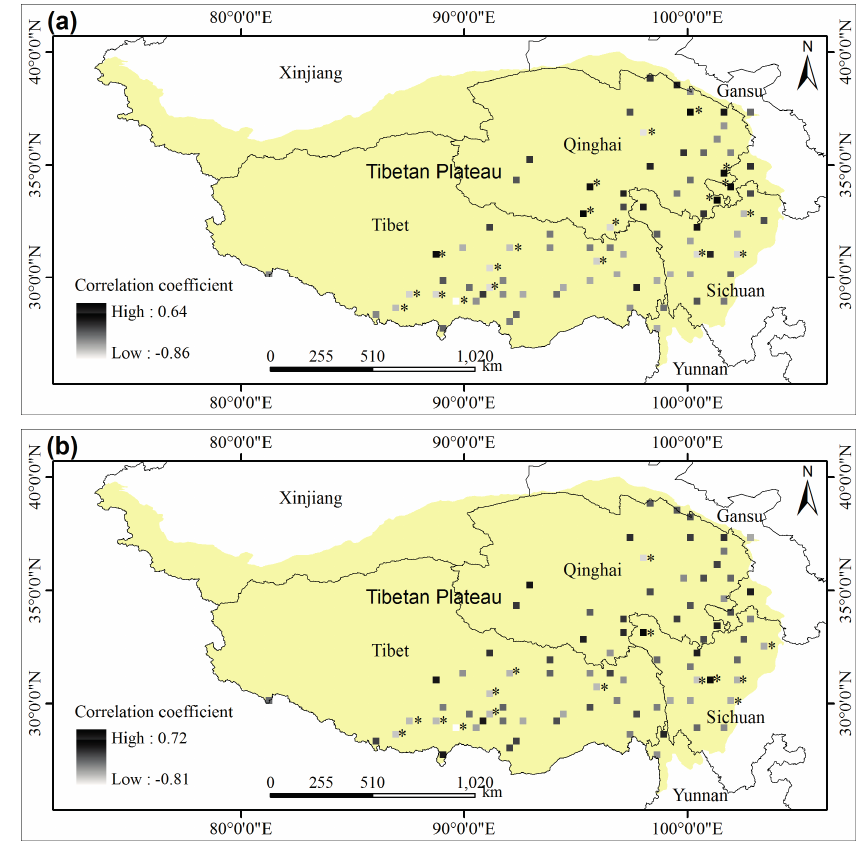
Figure 8. Correlation coefficients of the growing season maximum enhanced vegetation index (MEVI) with: ( a ) the average temperature (GAT); ( b ) maximum temperature (GMAT); ( c ) minimum temperature (GMIT); ( d ) total precipitation (GTP); ( e ) maximum precipitation (GMAP); ( f ) average vapor pressure (GAE); ( g ) average relative humidity (GARH); ( h ) minimum relative humidity (GMIRH); and ( i ) average vapor pressure deficit (GAVPD); from 2000 to 2012 at 81 meteorological stations on the Tibetan